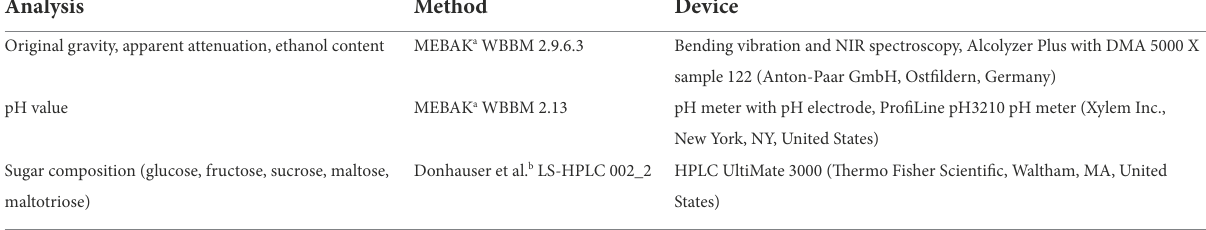
TABLE 3 Analytical methods of the wort and the beers according to MEBAK a and Donhauser et al. b . Analysis